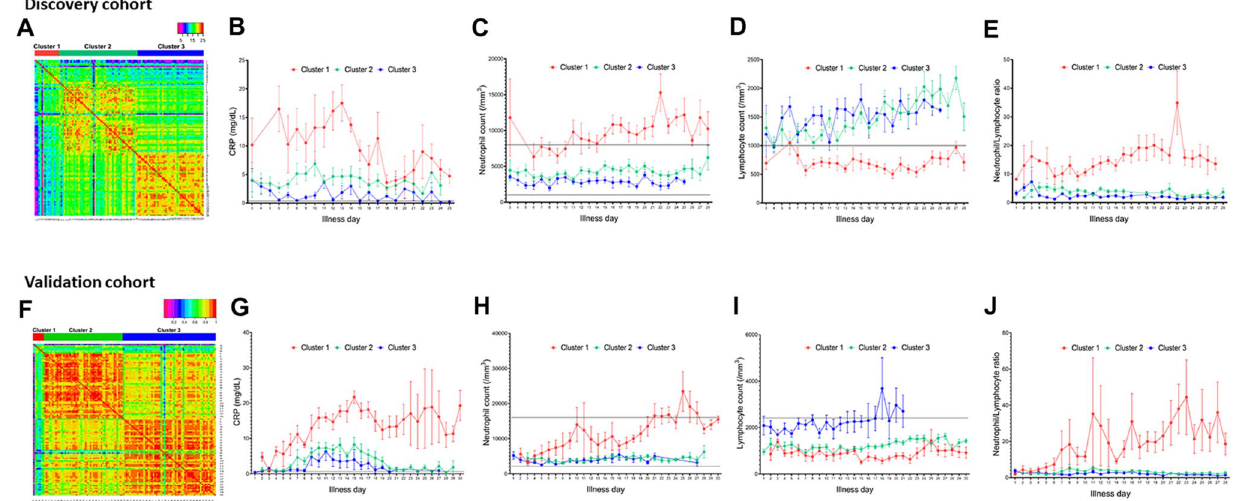
Figure 2. Unbiased clustering of inflammatory responses in those with COVID-19 infection in discovery and validation cohort. Heat map showed three distinct patterns of inflammatory immune response in 105 COVID- 19 patients of discovery cohort ( A ) and 116 patients in validation cohort ( F ). Colors indicate the similarity between patients (red = high similarity, violet = low similarity). Changes in C-reactive protein levels in discovery cohort ( B ) and validation cohort ( G ), changes in absolute neutrophil counts in discovery cohort ( C ) and validation cohort ( H ), changes in absolute lymphocyte count in discovery cohort ( D ) and validation cohort ( I ), changes in neutrophil/lymphocyte ratio in discovery cohort ( E ) and validation cohort ( J ) in each cluster are depicted. “Illness day” denotes the number of days from first symptom onset. Horizontal lines indicate the normal ranges. CRP, C-reactive protein. Data are expressed as the mean ± standard